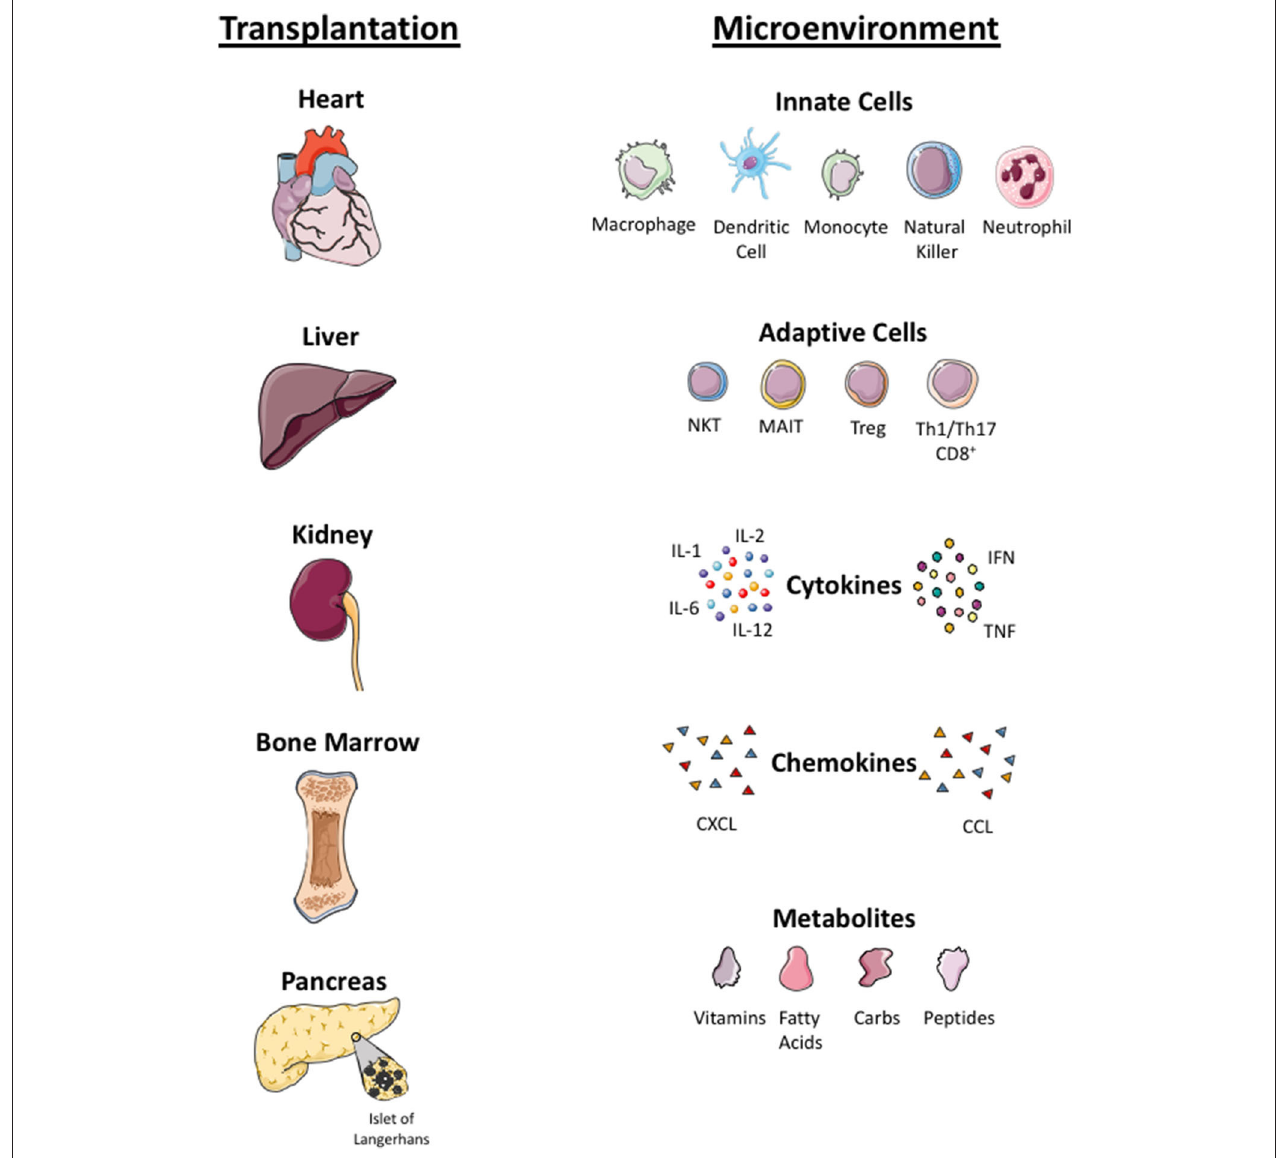
FIGURE 3 | Microenvironmental factors in different organs. Local tissue microenvironmental factors in organ (heart, liver, kidney, bone marrow, islet cells) transplantation. Infused Treg cells arrive to local tissue where they crosstalk with innate immune cells (macrophage, dendritic cells, monocyte, natural killer cells, neutrophils) and adaptive immune cells (NKT, Mucosa associated invariant T cells, Treg, Th1, Th17 cells) in the local tissue. Treg cells localize in tissue with pro-inflammatory cytokines (interleukin 1, 6 and 12, tumor necrosis factor (TNF) and interferon (IFN)), chemokines (CXCL and CCL) and local metabolites (carbohydrate, fatty acid, peptides and vitamins). Infused Treg cell plasticity and their function in the local tissue microenvironment is dependent on these factors. approach in recipients of kidney transplant to minimize the burden of general